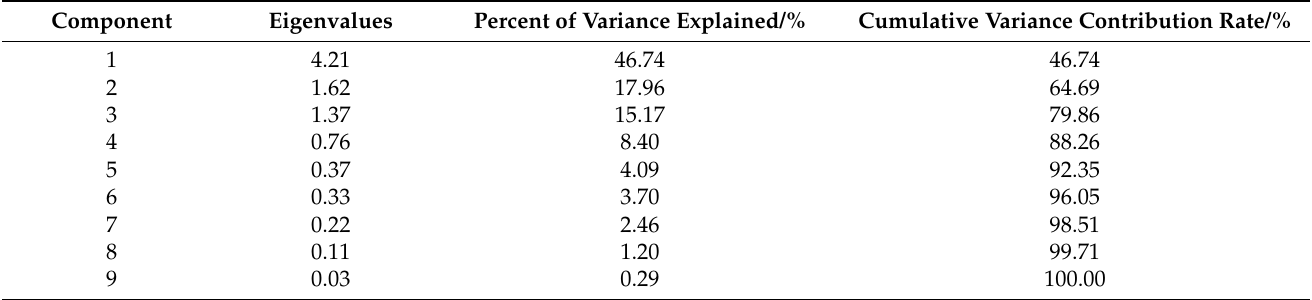
Table 2. Eigenvalues and cumulative contribution rates of nine variances.